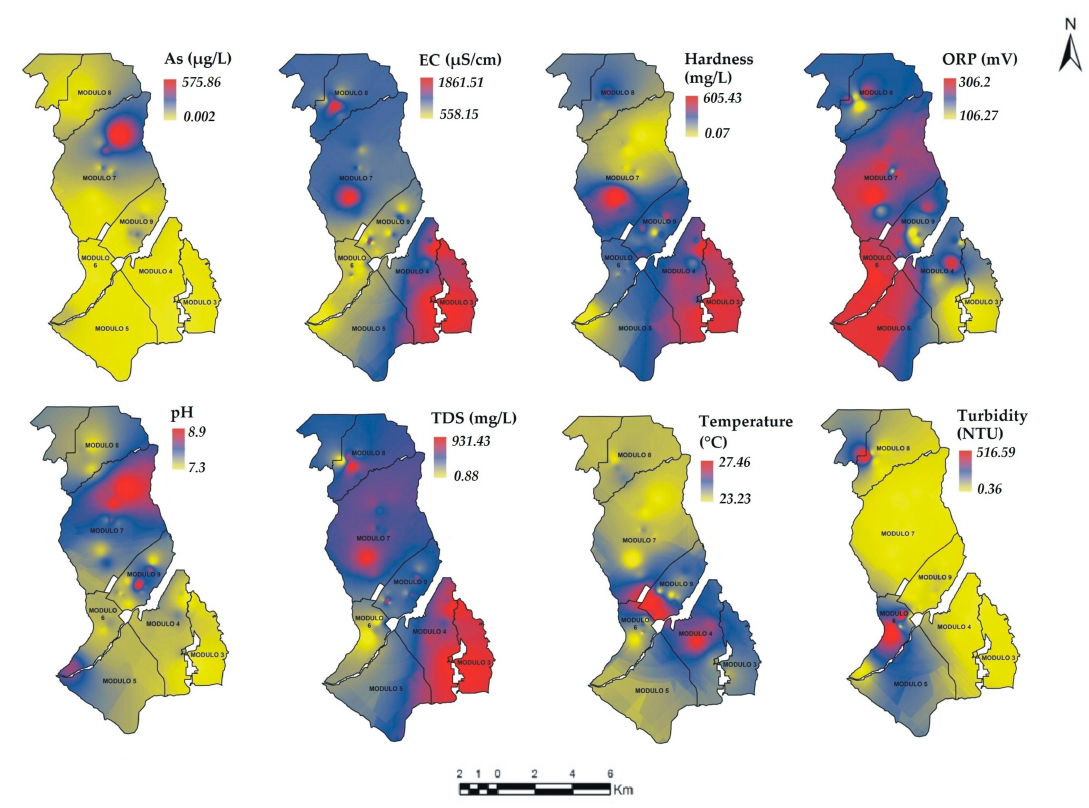
Figure 7. Spatial distribution of the PhP in the ID005 for S2, As = Arsenic, EC = Electrical Conductivity, pH = pH, ORP = Oxide Reduction Potential, studied modules (—).